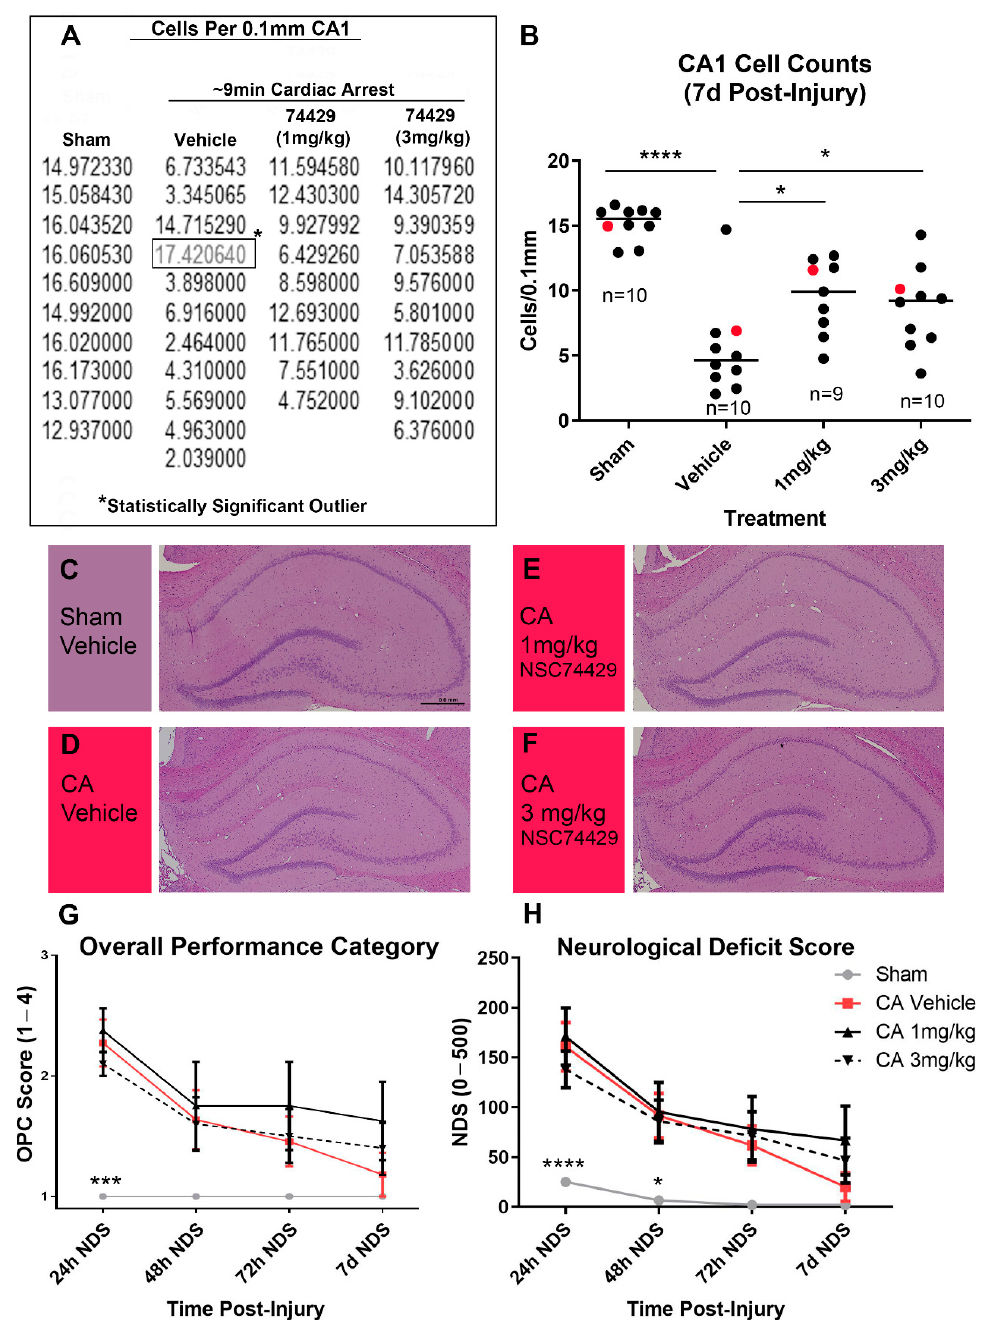
Figure 3. Evaluation of NSC74429 Mediated Neuroprotection in a Rat Model of Cardiac Arrest. ( A , B ) Normalized CA1 cell count values are shown along with the associated scatter plot. A single CA1 cell count outlier was confirmed by the ROUT method (indicated by the *) and removed prior to statistical analysis of histology. Individual data points highlighted in red in the scatter plot cor- respond to the rat brains selected as representative images. ( C – F ) Representative images of H&E- stained brains used to assess CA1 cell loss. ( G , H ) Line graphs (mean + SEM) show changes in overall performance category (OPC) and neurological deficit score (NDS) testing measured in the first 72 h post-injury and at 7 d post-injury. Asterisks indicate significance compared to vehicle-injured rats. Data were significant at p < 0.05. (*) = p < 0.05, (***) = p < 0.001, (****) = p < 0.0001.